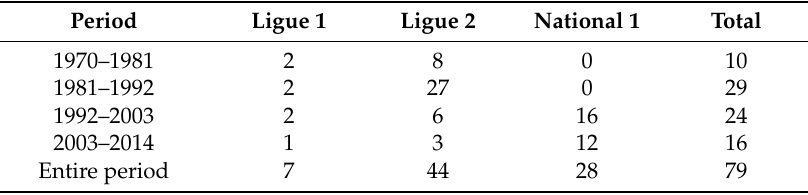
Table 7. The number of payment failures in French football, 1970–2014. Period Ligue 1 Ligue